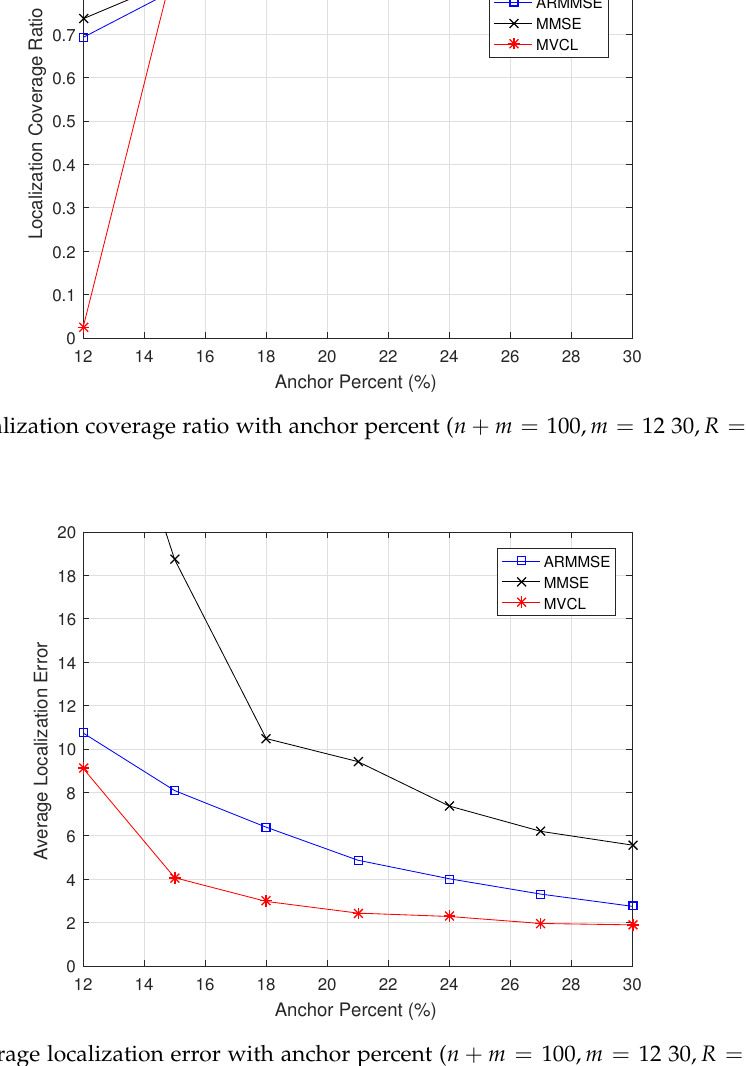
Figure 14. Average localization error with anchor percent ( n + m = 100, m = 12 30, R = 30, k = 4, ζ = 15, η =